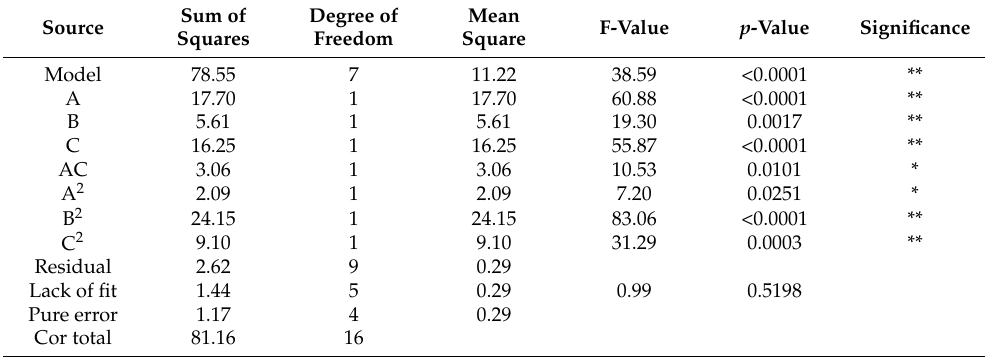
Table 8. Regression model optimization analysis of variance. Sum of Degree of Source Squares Freedom